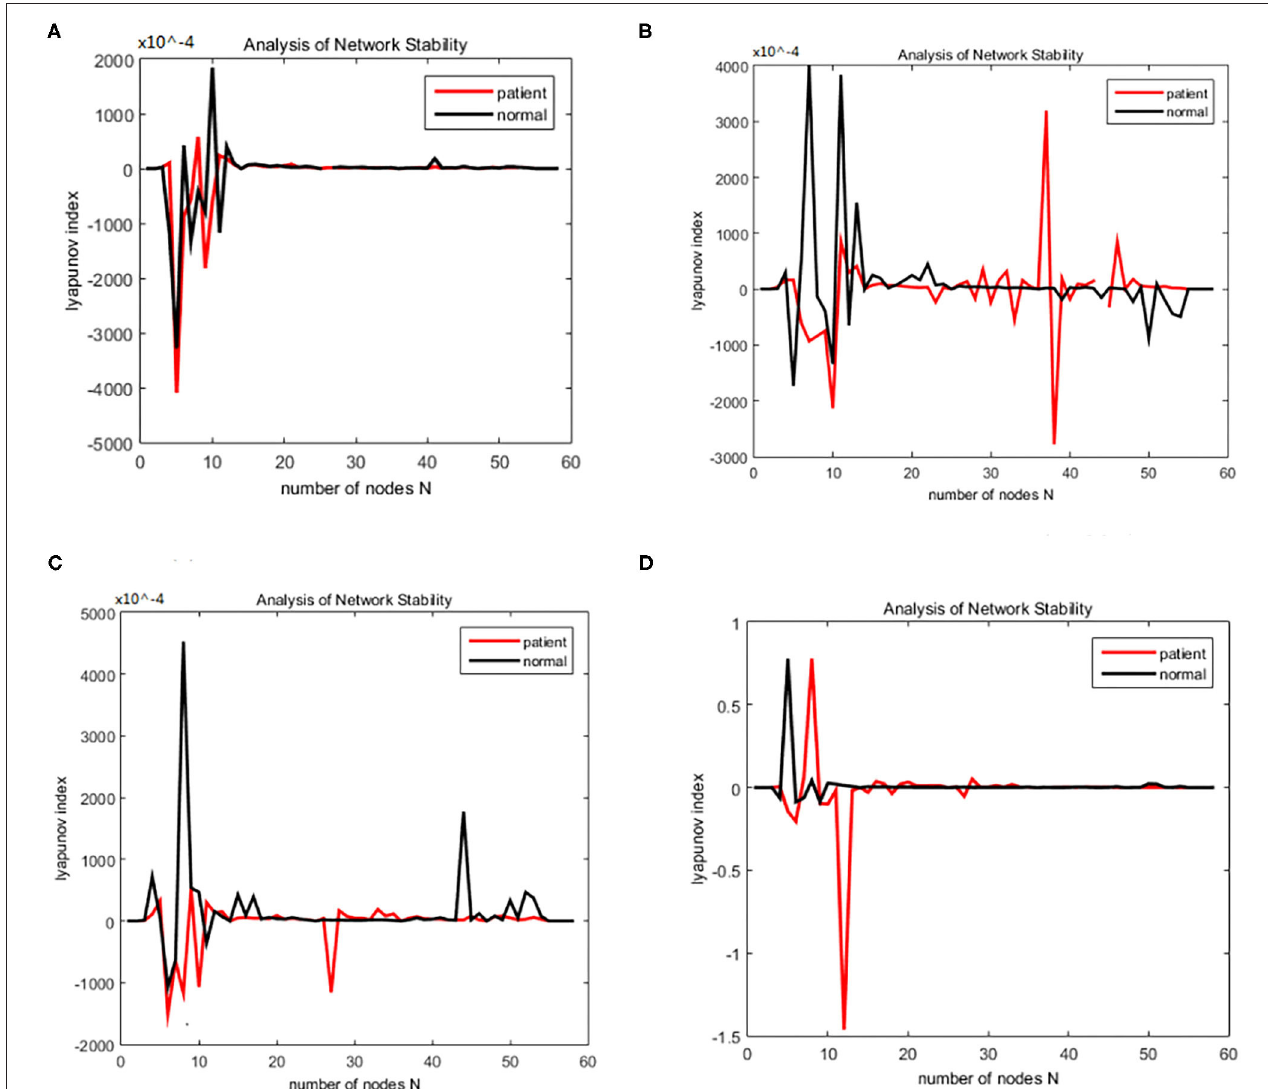
FIGURE 8 | Bain network synchronization experimental results of the same subject in Schizophrenia data set under different connection densities. (A) Connection density 30%, (B) connection density 32%, (C) connection density 34%, (D) connection density